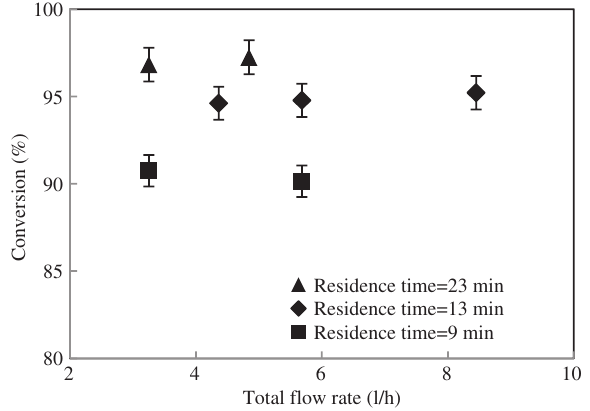
Figure 8 Reaction conversion in the COBR for different net flow rates but constant residence